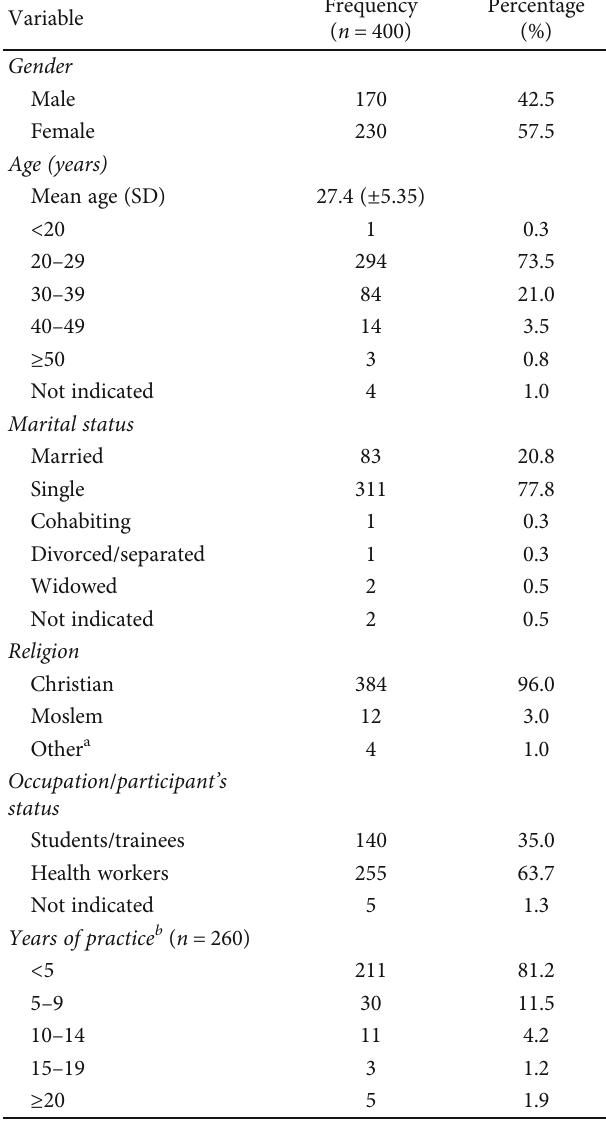
Table 1: Demographic characteristics of study